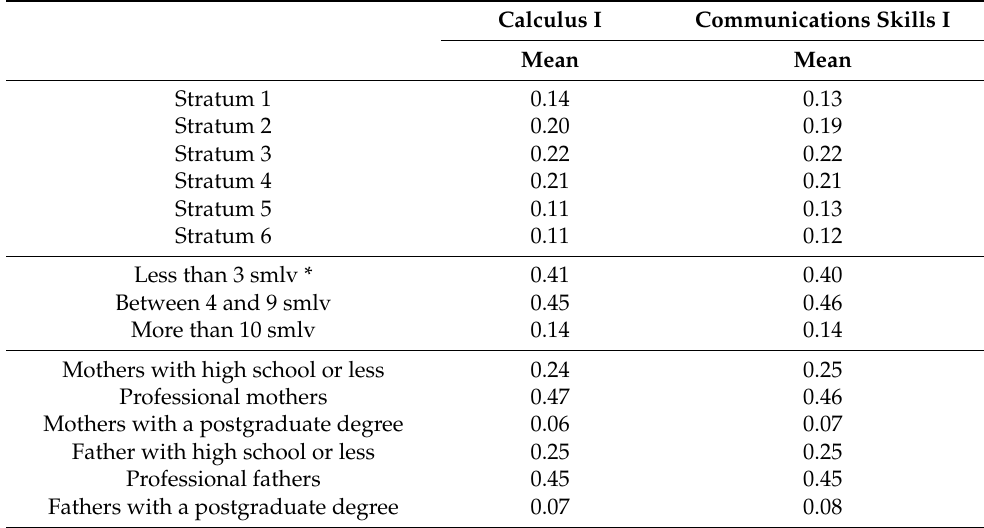
Table 2. Students’ socioeconomic origin statistics.